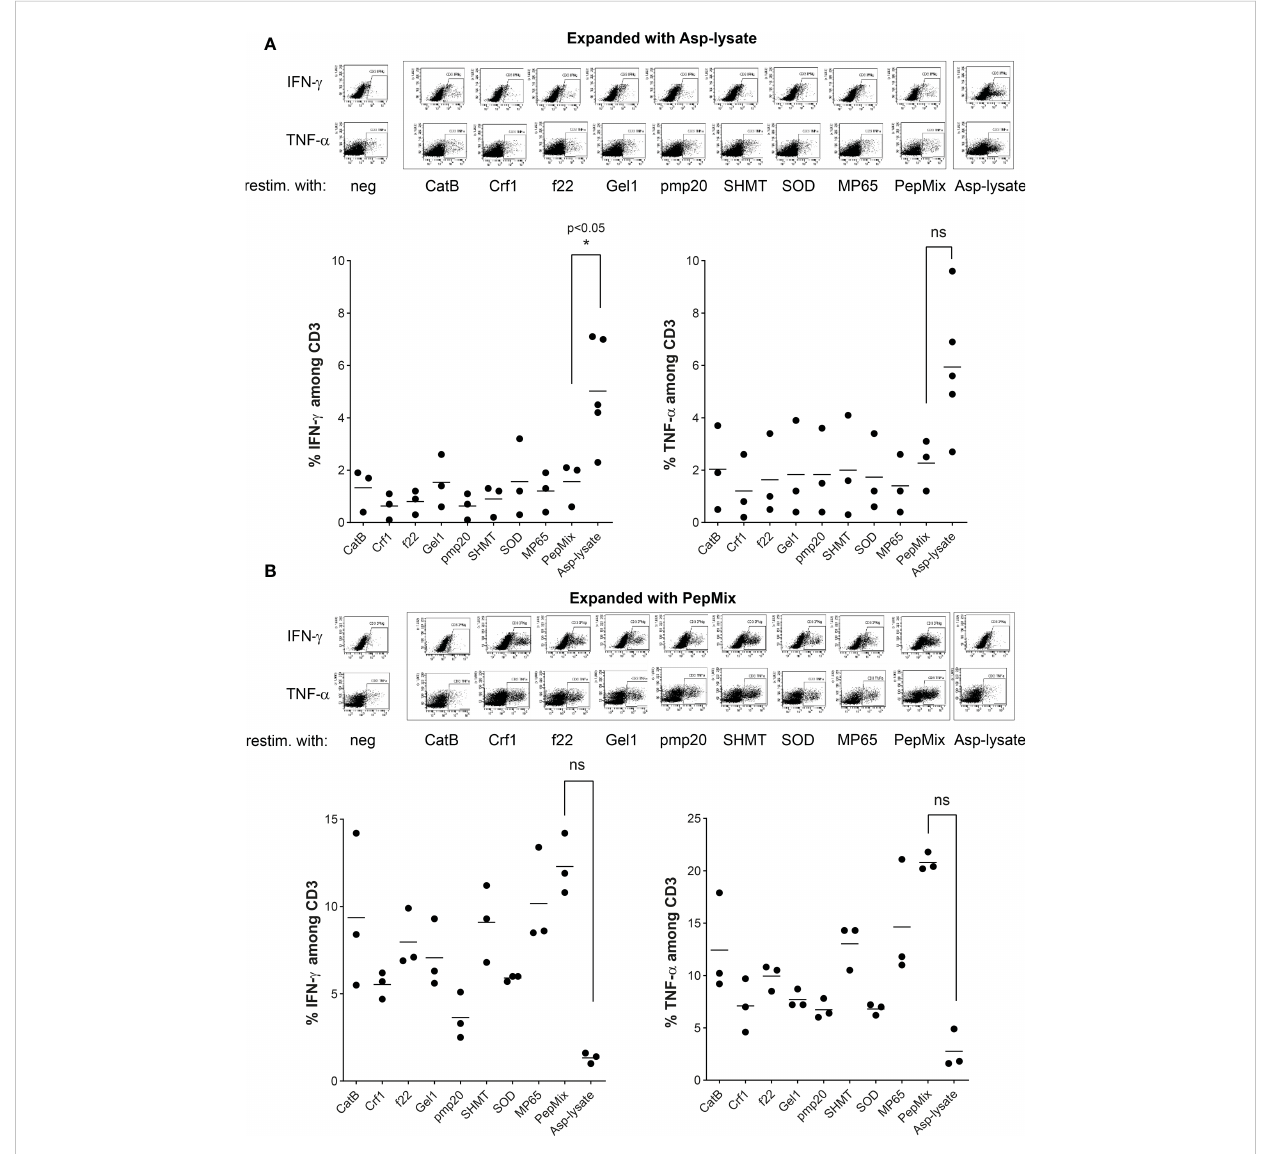
FIGURE 5 Intracellular cytokine staining of IFN- g and TNF- a producing ATCs. PBMCs were short-term expanded (STE) for 12 days with either the (A) Asp-lysate (50 µg/ml) or a (B) combination of eight fungal peptide pools termed PepMix (1 µg per peptide/ml per peptide pool, composed of: CatB, Crf1, f22, Gel1, pmp20, SHMT, SOD and MP65 peptide pool) . Representative dot plots (gated on CD3 + T cells) and percentage values of IFN- g - and TNF- a - expressing CD3 + ATCs, expanded with either (A) Asp-lysate or (B) PepMix and restimulated with indicated antigens (x-axis) are shown. Diagrams include the mean values obtained from n=3-5 individual HDVs from the cohort of donors (n=320), pre-tested for the presence of Asp-speci fi c T cells. Dot plots highlighted in grey represent cells expanded and restimulated including the same antigen. Background values, based on unstimulated cells (neg) were subtracted. Data are shown in total as individual result and mean. Statistically signi fi cant difference is indicated by (*p<0.05), ns – not signi fi